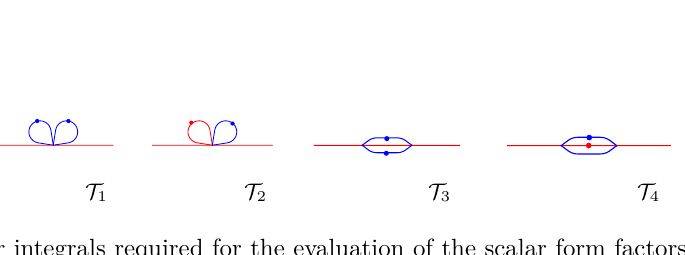
Figure 8. Master integrals required for the evaluation of the scalar form factors in the soft limit, t → 0 . The diagrams contain fermions with mass m ‘ (blue lines) and m N (red lines). External fermions are